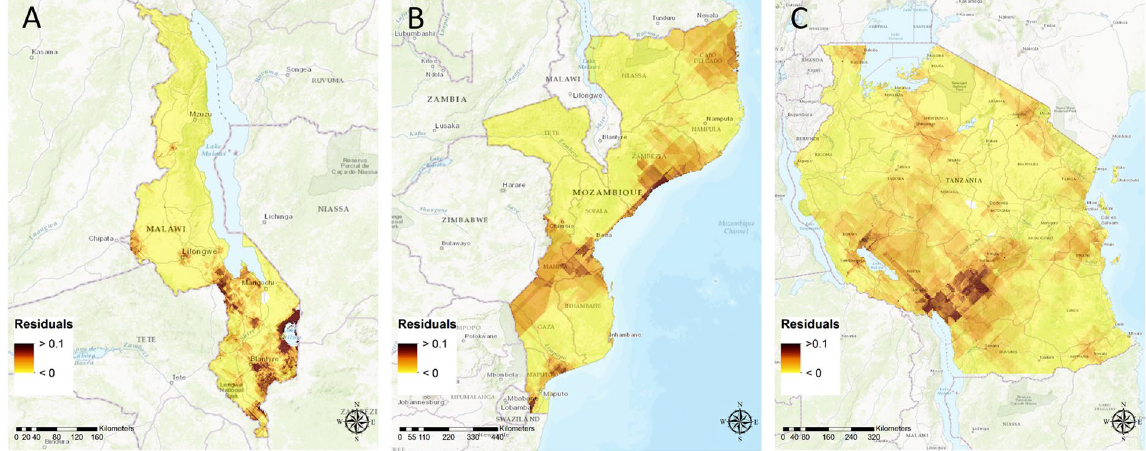
Figure 5. Kriging interpolation of residuals from multivariable logistic regression models for data from ( A ) Malawi; ( B ) Mozambique; and ( C ) Tanzania. Maps were created using ArcGIS ® software by Esri version 10.3 42